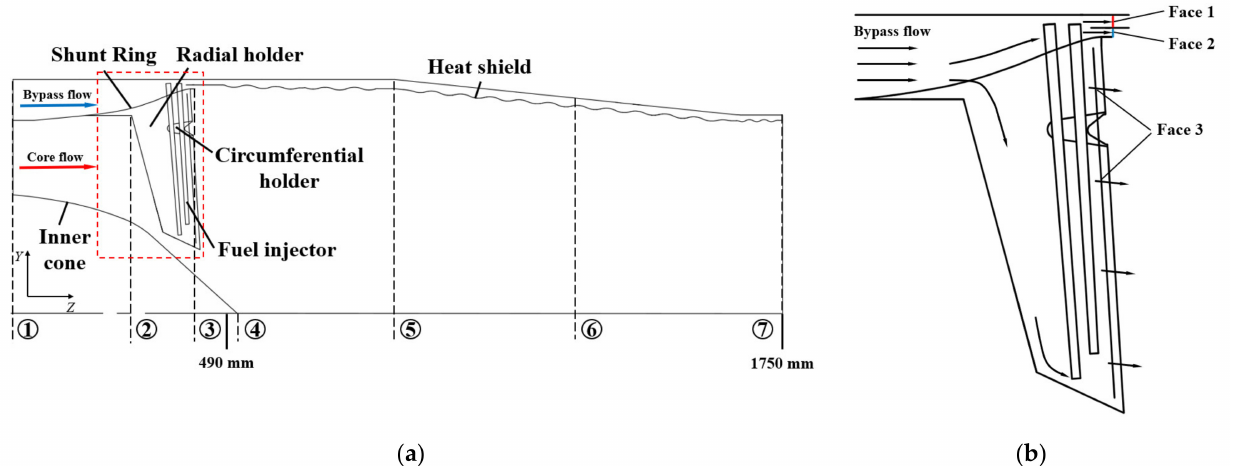
Figure 2. 2-D structure schematic of the integrated afterburner and layout of the cross-section: ( a ) 2-D structure schematic; ( b ) partially enlarged view of radial